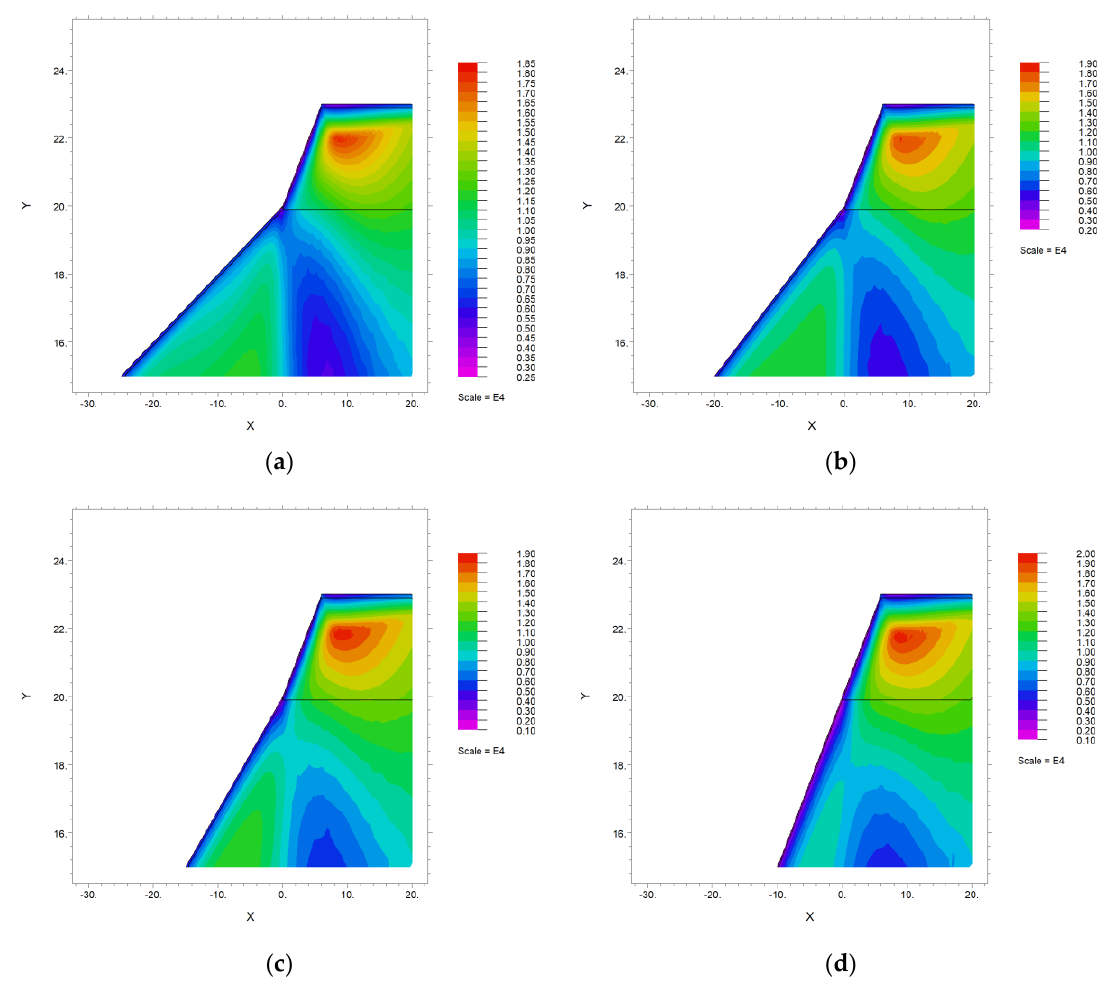
Figure 11. Coulomb – Mohr potential for the sand-type subsoil, for underwater slope inclinations of ( a ) 1:5, ( b ) 1:4, ( c ) 1:3, ( d ) 1:2 (negative values indicate compressive stresses in Pa, and positive val- ues — tensile stresses in Pa).